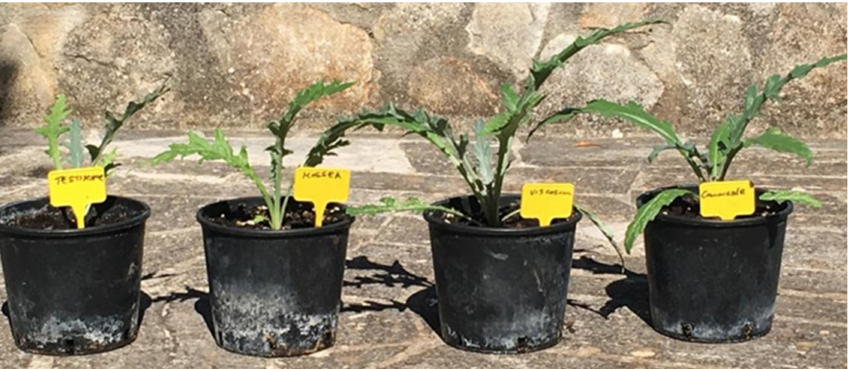
Figure 5. From the left to the right, a control plant and plants with root system inoculated with spores of F. mosseae , S. viscosum , and a commercial mycorrhiza mix after 1 month of outside